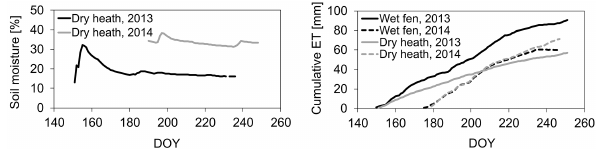
Figure 8. Development of soil moisture conditions (10cm depth) and evapotranspiration (ET). Mean daily soil moisture content at the dry heath (left panel) and cumulative ET at the wet fen and dry heath during the growing season in 2013 and 2014 (right